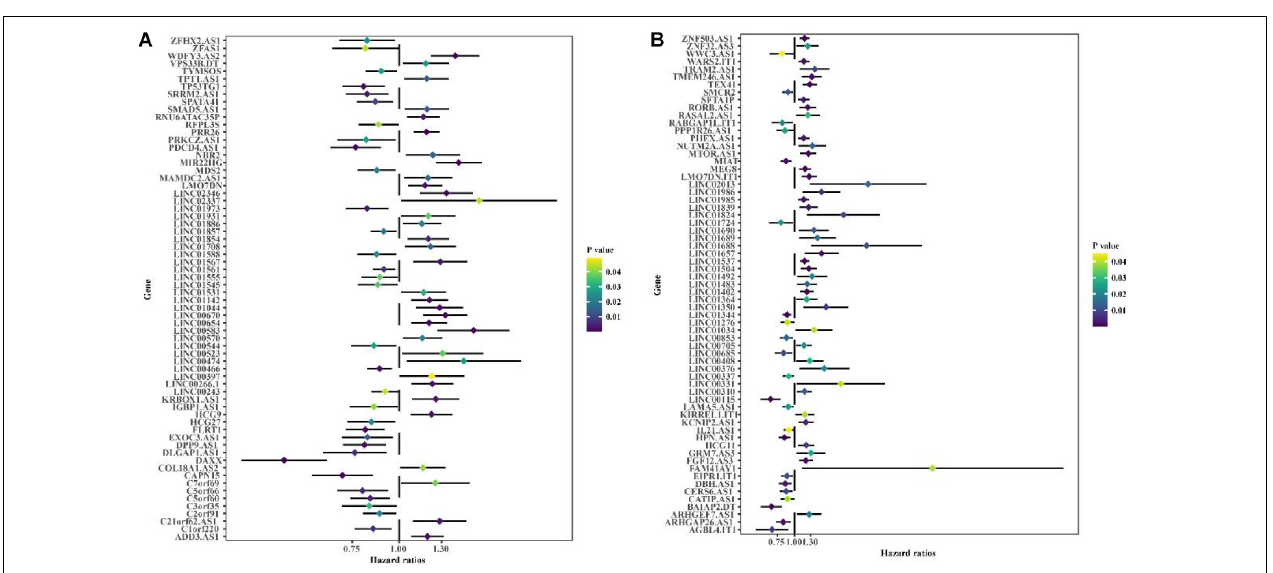
FIGURE 2 | Univariate Cox regression is used to identify the forest graph of 166 immune-associated lncRNAs related to prognosis. (A) Part A of 166 immune-associated lncRNAs. (B) Part B of 166 immune-associated lncRNAs. The yellower the color is, the higher the p value; the bluer the color is, the smaller the p